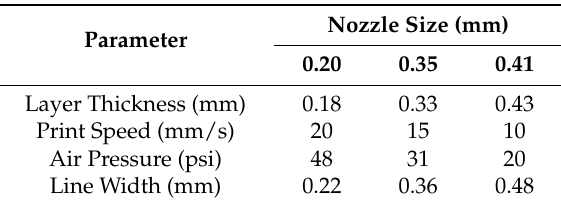
Table 1. Printing parameters used in this